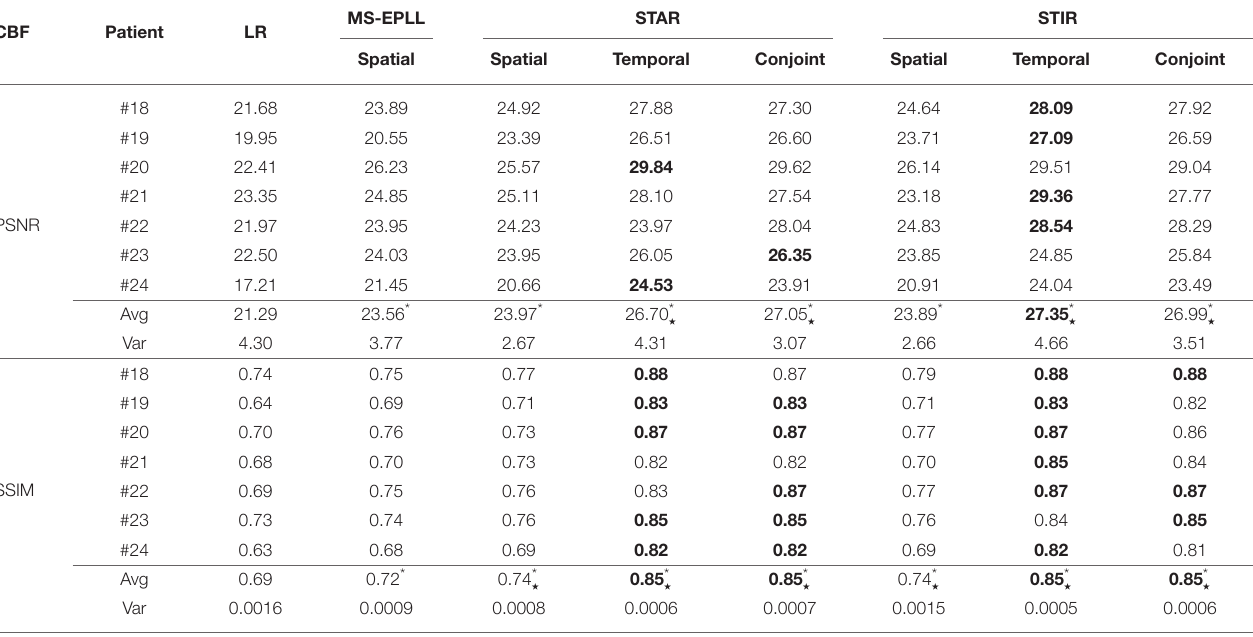
In this table, three methods are compared: MS-EPLL, STAR, and STIR-Net. LR means the PSNR value for the noise image after down-sampling. The best values are highlighted for different patients. The average value and the variance are listed at the bottom of the table. The asterisk symbol denotes the result of the current method achieves significant higher